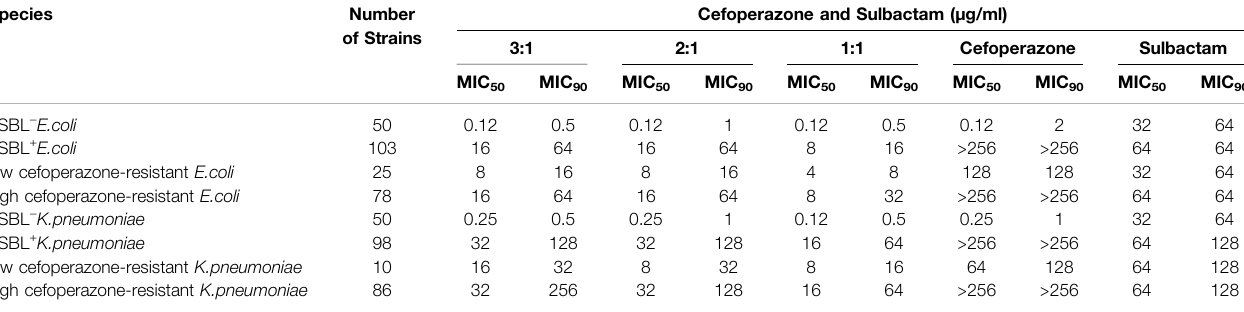
TABLE 1 | MIC of cefoperazone sodium, sulbactam sodium and cefoperazone/sulbactam combinations (3:1, 2:1 and 1:1) against clinical isolates of E.coli and K.pneumoniae . Species Number Cefoperazone and Sulbactam ( μ g/ml) of Strains